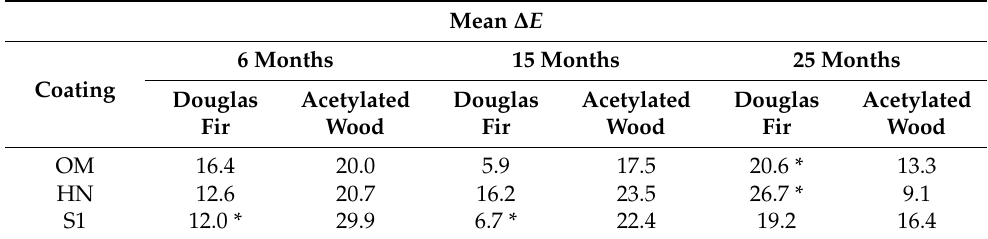
Table 2. The ability of different coatings to protect Douglas fir heartwood and acetylated radiata pine sapwood from UV damage as measured by ∆ E for each species/coating combination over a 25-month exposure at two sites with differing climates. * indicates significant differences between each species/coating combination as determined by Welch’s